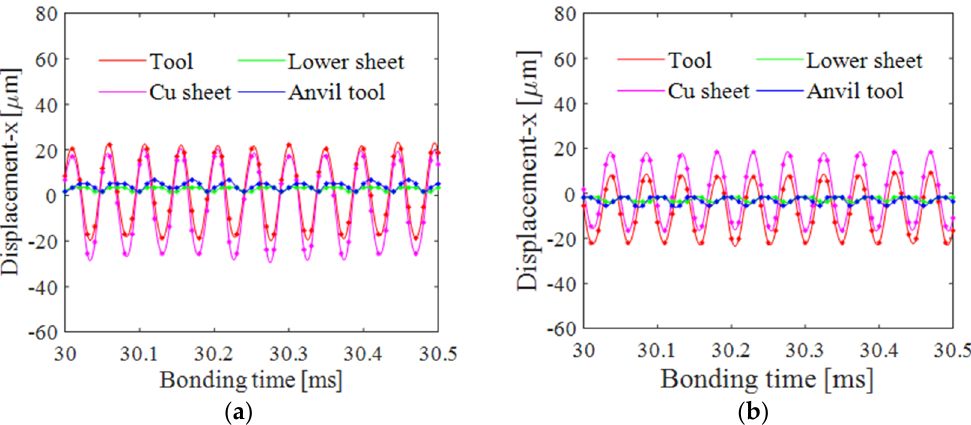
Figure 10. Displacement along the vibration direction ( x -axis) at 30 ms ( a ) using the K-type tool and ( b ) using the C-type tool.